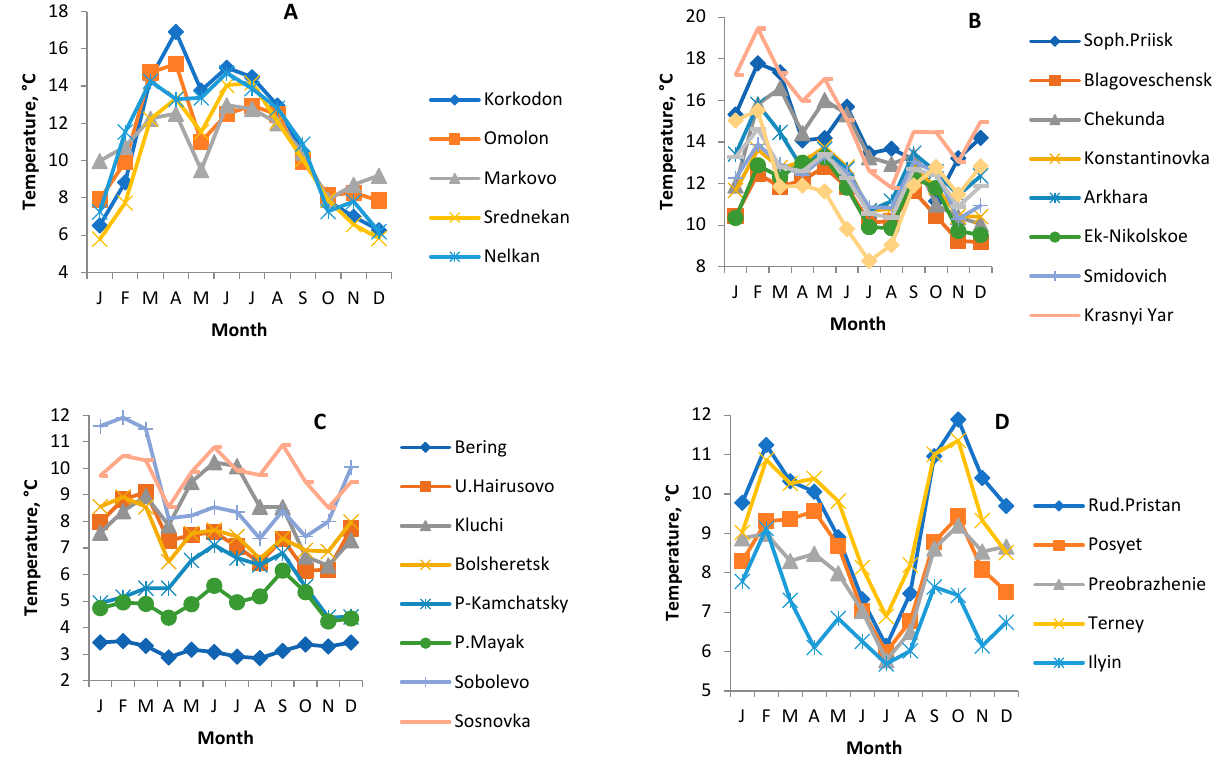
Figure 4. Intra-annual fluctuations of DTR from January to December in several locations in the RFE; continental ( A , B ), coastal ( C , D ); northern ( A , C ), southern ( B , D ).